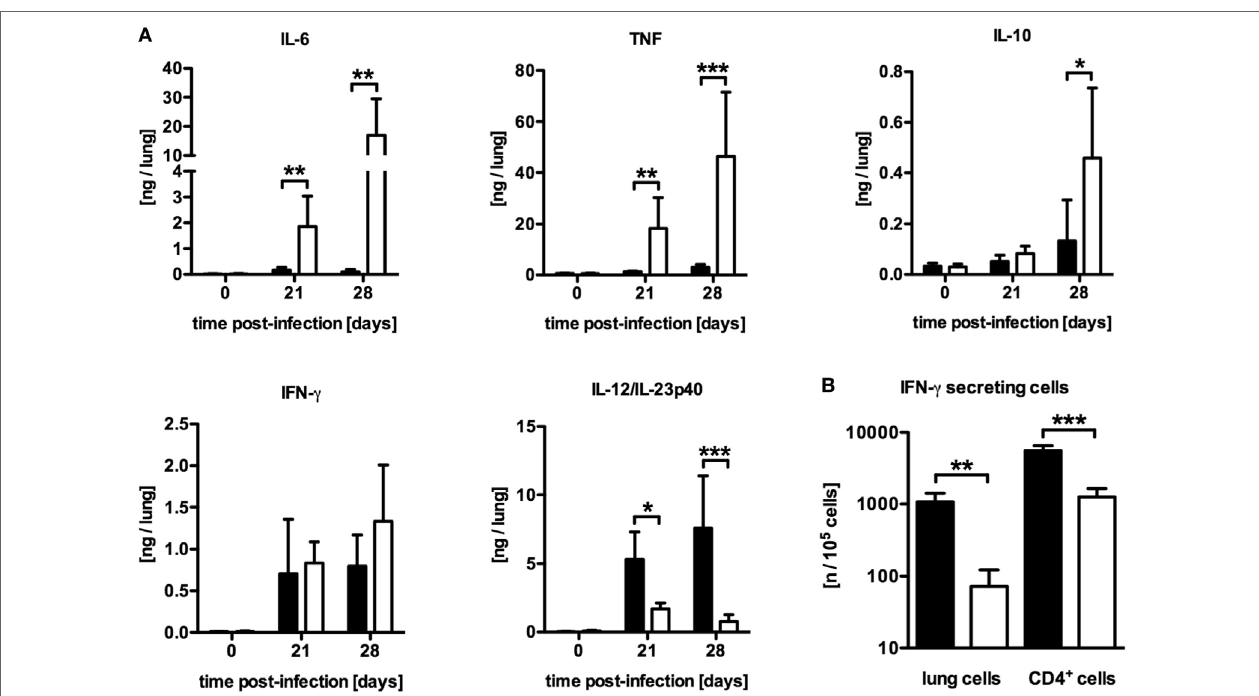
FigUre 2 | Differentially expressed inflammatory immune responses in Mtb -infected LysM cre SOCS3 loxP/loxP mice. Cre-negative SOCS3 loxP/loxP control mice (black symbols) and LysM cre SOCS3 loxP/loxP mice (white symbols) were infected with approximately 1,000 CFU Mtb via the aerosol route and lungs were isolated at the indicated time points. (a) Cytokine levels were measured by cytometric bead array (CBA) in lung homogenates and the quantity of cytokines per lung was calculated based on the ratio of lung to sample weight. (B) At 23 days of infection, perfused lungs were digested and single-cell suspensions, as well as enriched CD4 + T cells, were restimulated with ESAT-6 1–20 . The frequency of IFN- γ -producing cells was determined by an ELISPOT assay. Data represent means ± SD of at least five mice per group. One experiment representative of two performed is shown. Statistical analysis was performed as described in experimental procedures defining differences between SOCS3 loxP/loxP and LysM cre SOCS3 loxP/loxP mice as significant (* p ≤ 0.05; ** p ≤ 0.01; *** p ≤